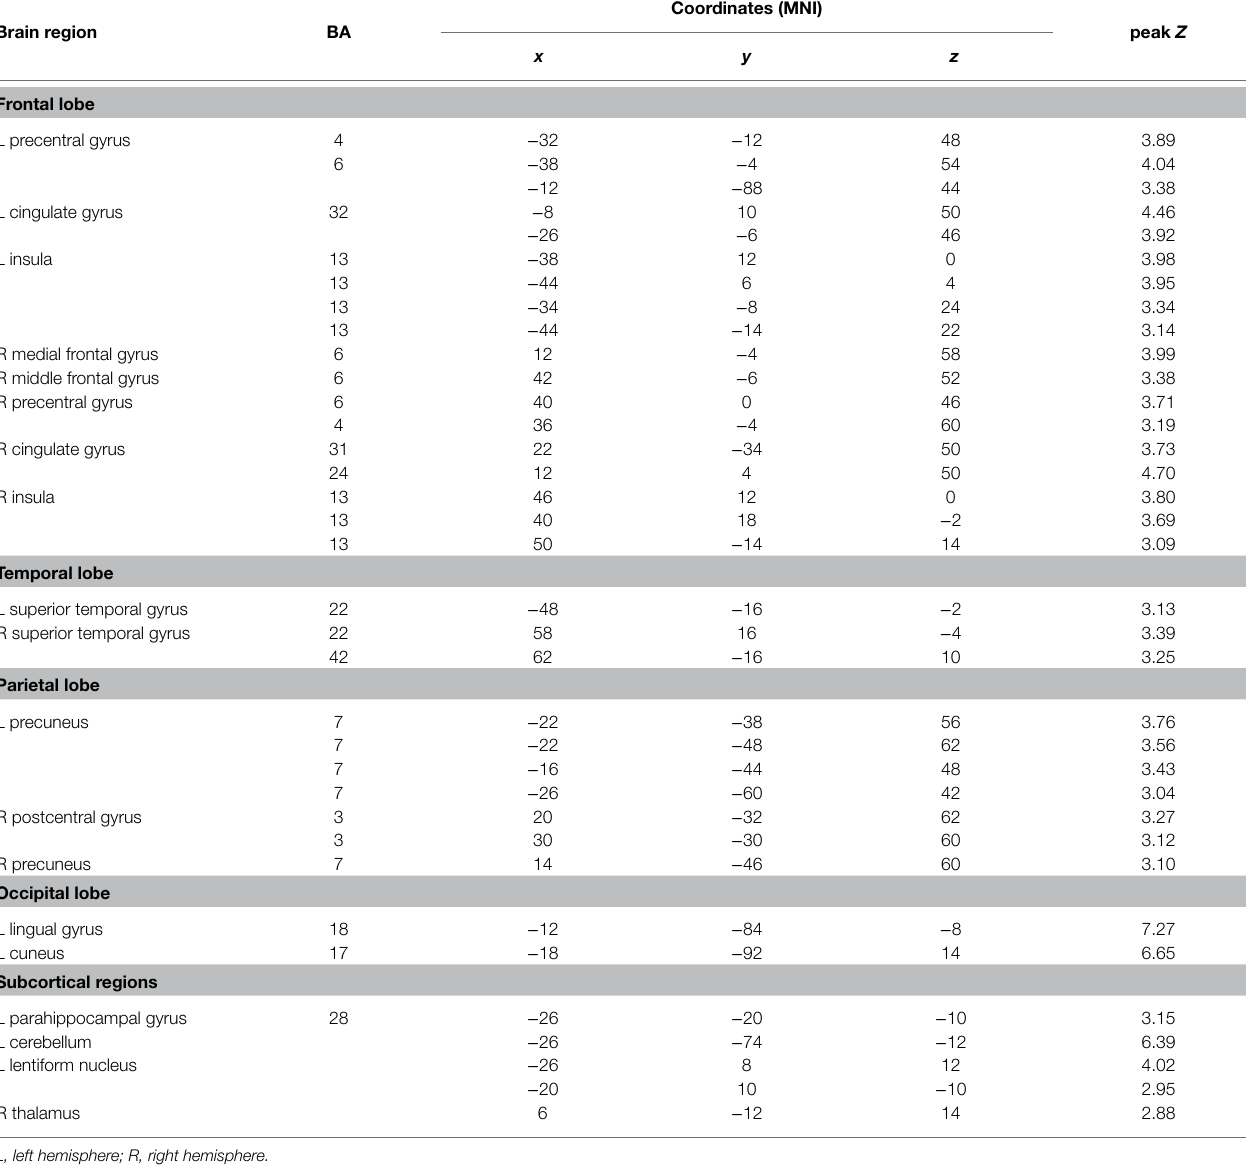
Coordinates (MNI)